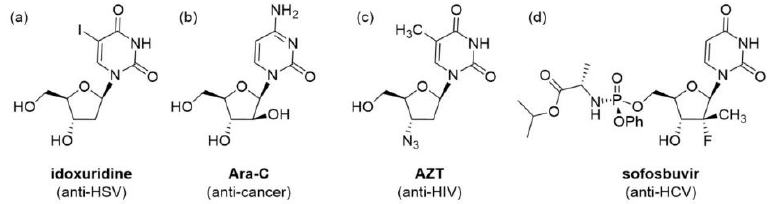
Figure 1. Examples of early modified nucleoside drugs ( a – c ) and the aryloxy phosphoramidate monophosphate prodrug sofosbuvir ( d